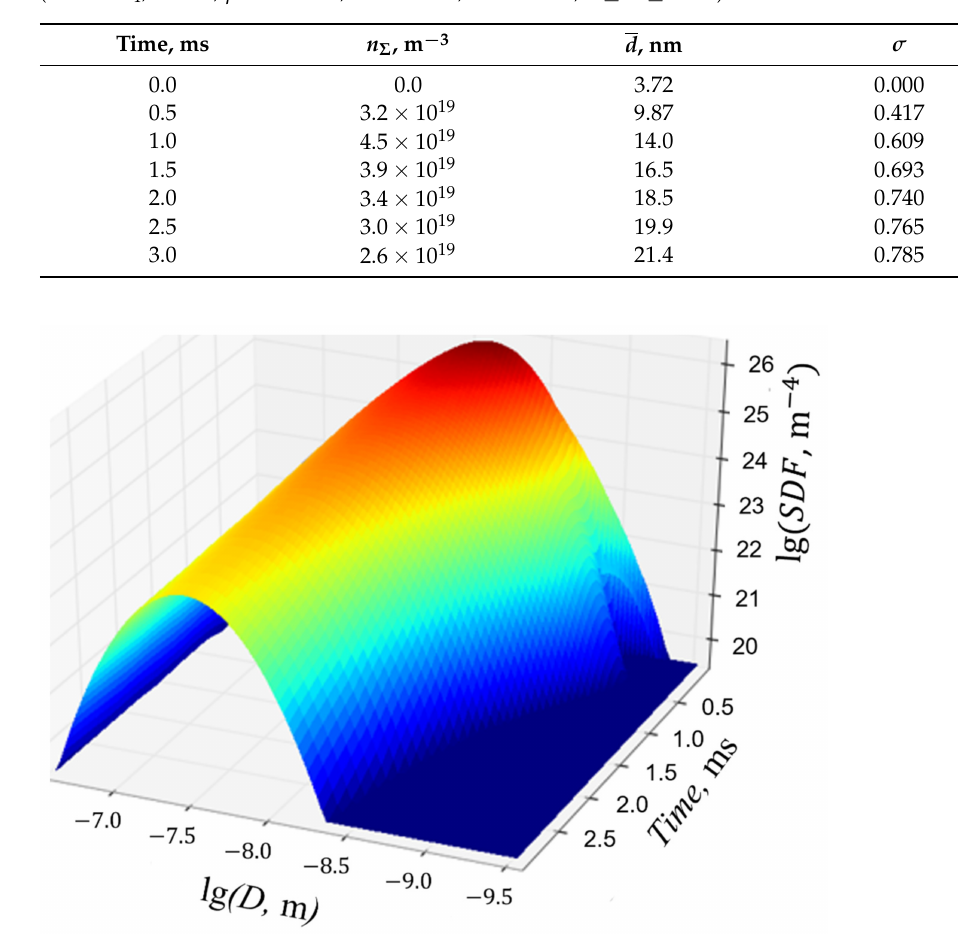
Table 2. A fragment of the look-up table for the parameters of the log-normal SDF of soot particles